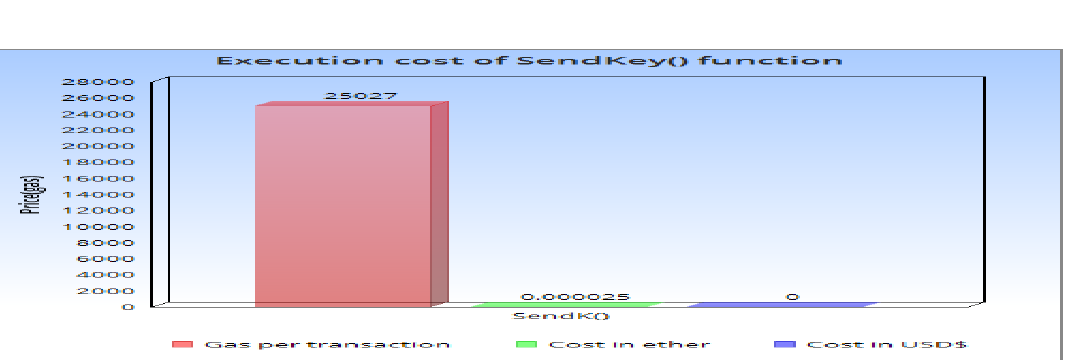
Fig. 6. Execution Cost of SendKey()